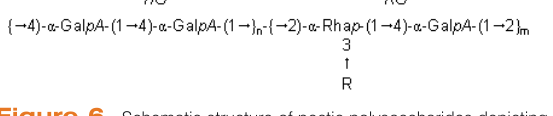
Figure 6. Schematic structure of pectic polysaccharides depicting the homogalacturonan (HG) and rhamnogalacturonan (RG) sequences in the pectin backbone with (R) the attached neutral side chains (arabinan, galactan,